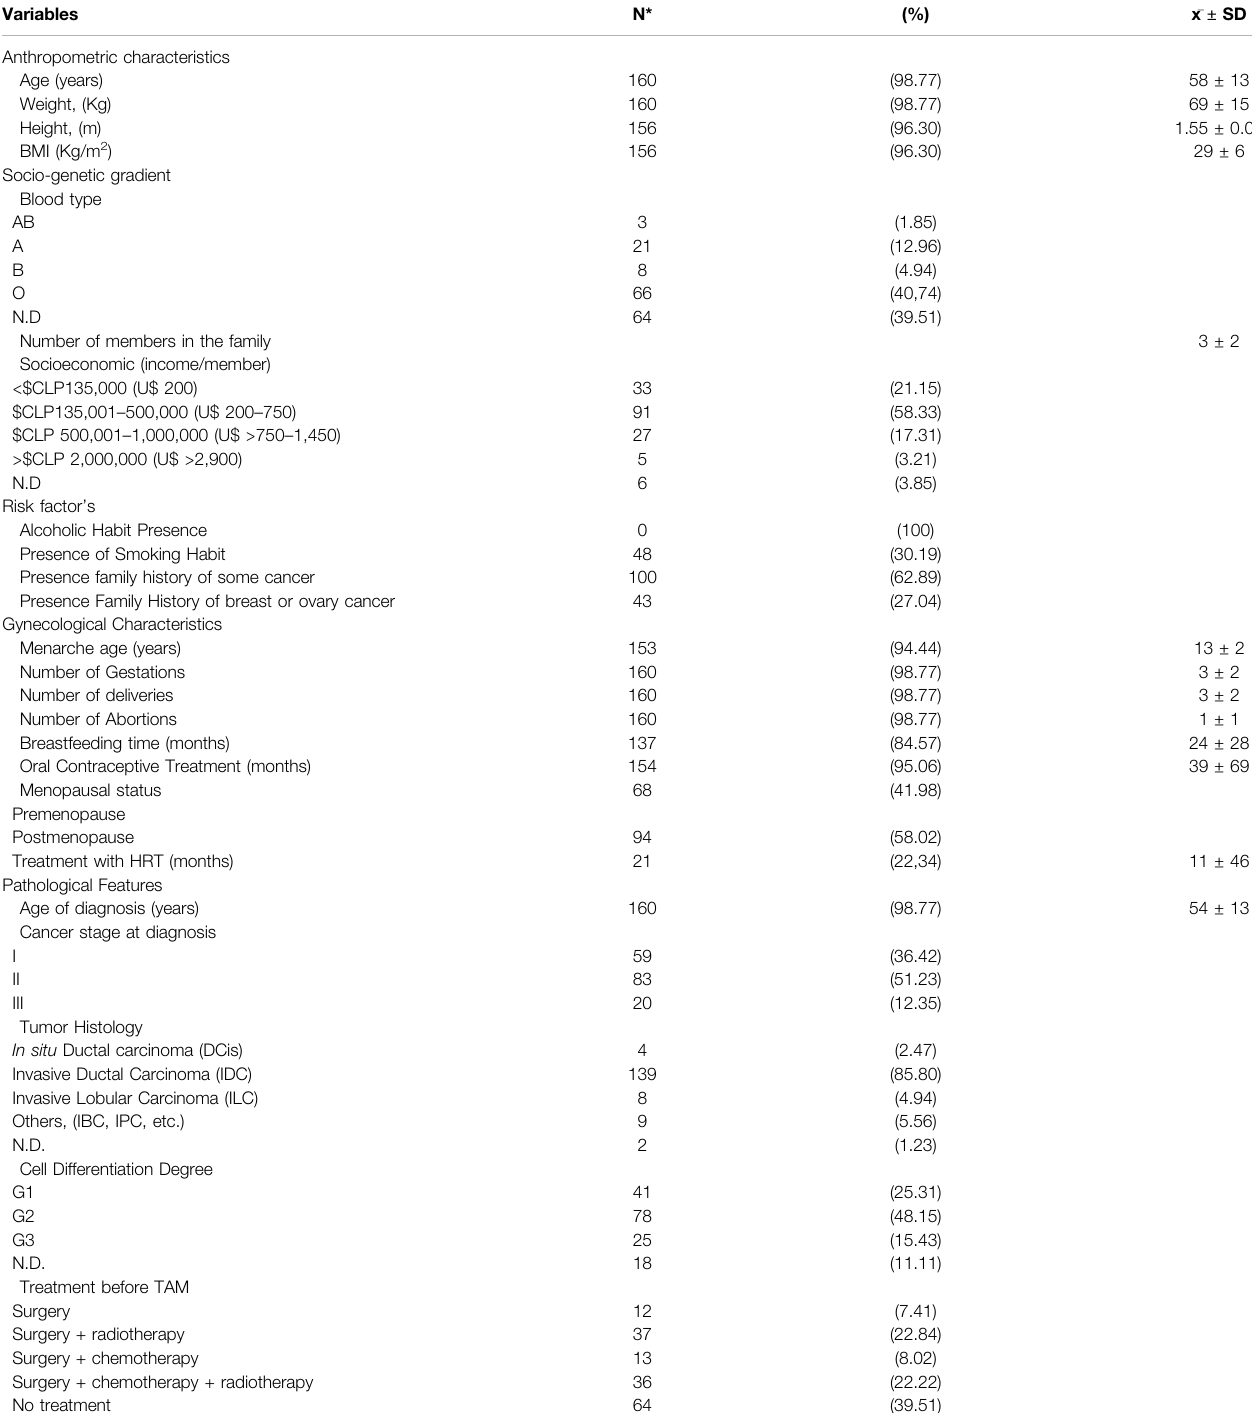
TABLE 1 | Characteristics of patients ( n (cid:1)